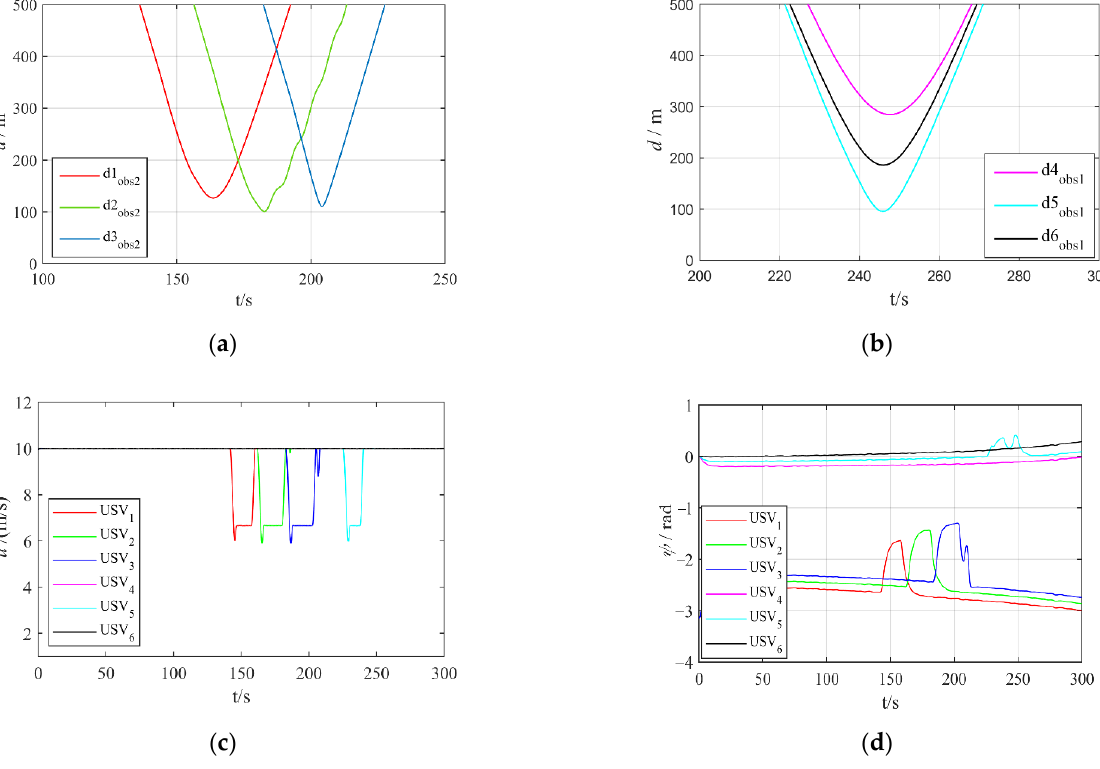
Figure 9. Detailed plots of the pursuer’s avoidance performance. ( a ) Distances between obstacle ship and pursuers in ambush group. ( b ) Distances between obstacle ship and and pursuers in ambush group. ( b ) Distances between obstacle ship and pursuers in pursuit group. pursuers in pursuit group. ( c ) Heading angle curves of pursuers in swarm. ( d ) Speed ( c ) Heading angle curves of pursuers in swarm. ( d ) Speed curves of pursuers in curves of pursuers in swarm.